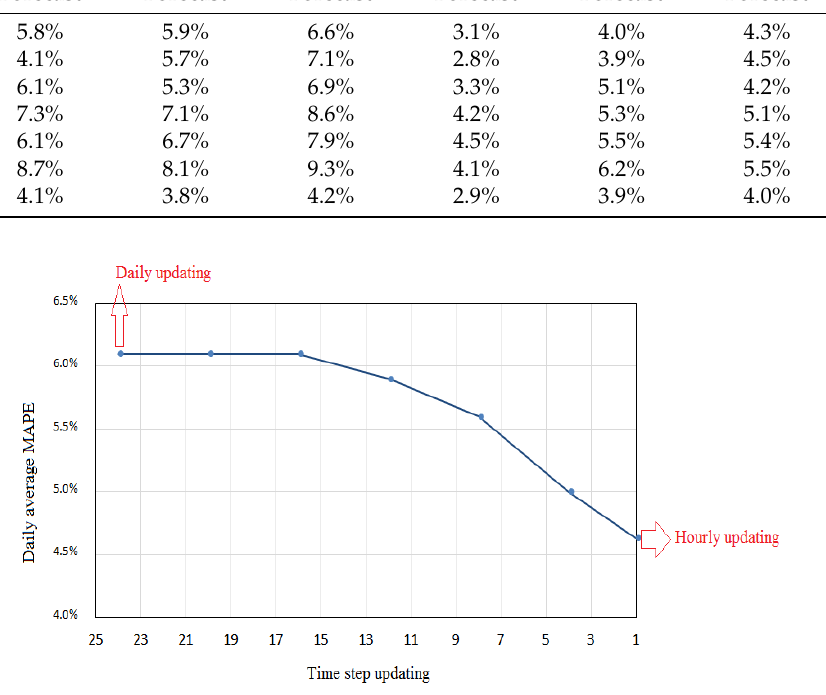
Table 8. The daily mean absolute percentage error (MAPE) for the rolling and fixed models started from 1 October 2020. Traditional ANN